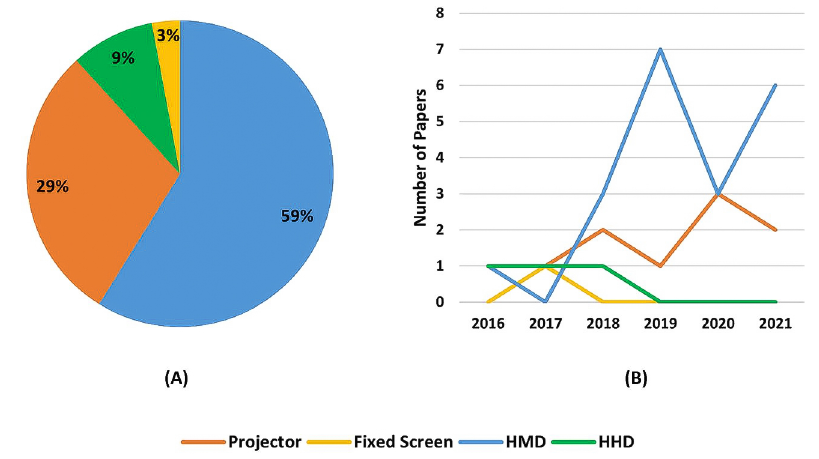
Figure 19. ( A ) Percentage of visualization methods; ( B ) user interface usage over time.